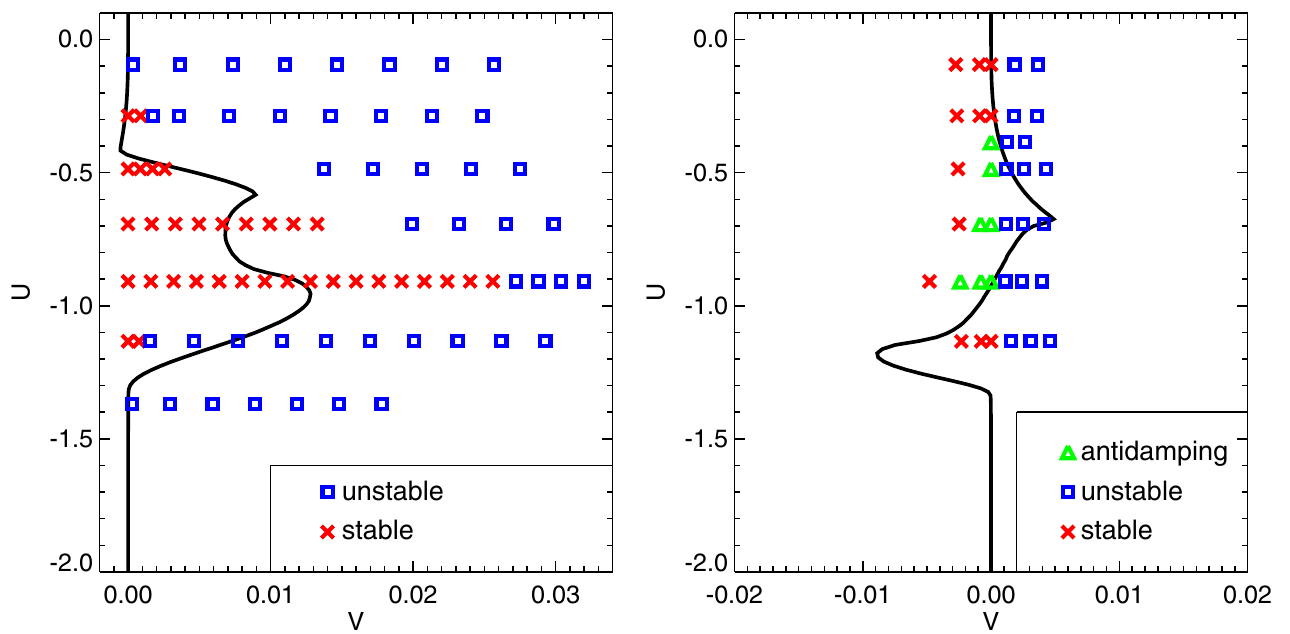
FIG. 5. (Color) Combination of nonlinear space-charge and an octupole with the advantageous polarity (left), disadvantageous polarity (right); simulations are made with the frozen electric field for a waterbag distribution. The symbols are the results of simulation runs; the lines are stability boundaries from the dispersion